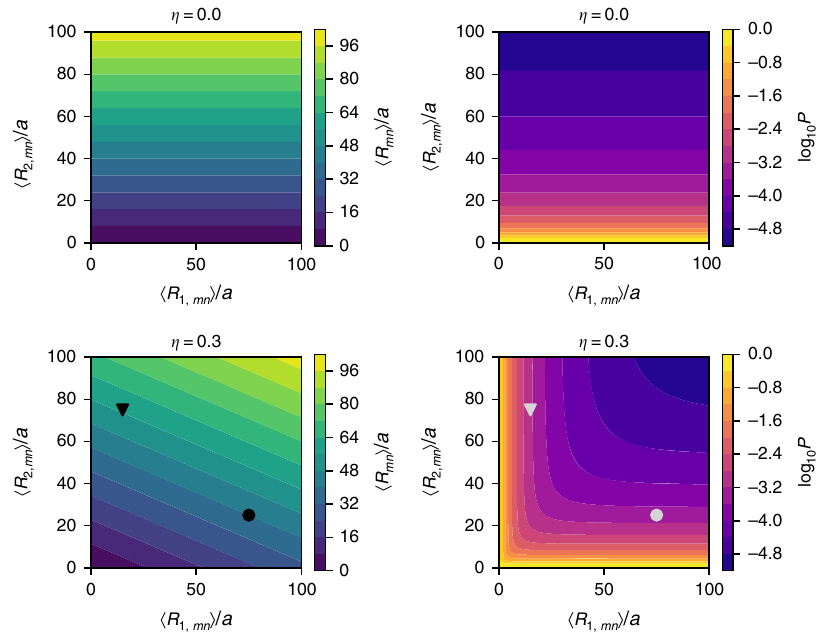
Fig. 3 Plots of mean distance 〈 R mn 〉 and the contact probability P mn as heatmaps computed using r c = 2 a . The colorbars on the right show the values of 〈 R 〉 and P η = 0( ≠ 0) is shown on the top panel (bottom panel). Two speci fi c pairs are marked as triangle and circle in the lower-left mn mn . The results for panel. These loci pairs illustrate the [ P mn , 〈 R mn 〉 ] computed as δ = 1/(1 − ν ). ν is inferred from scaling 〈 R ( s ) 〉 ~ s ν ,